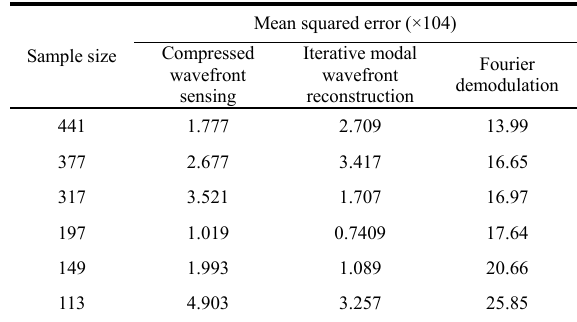
Table 1 Mean squared error of reconstructed wavefronts slopes with different methods at 6 sample